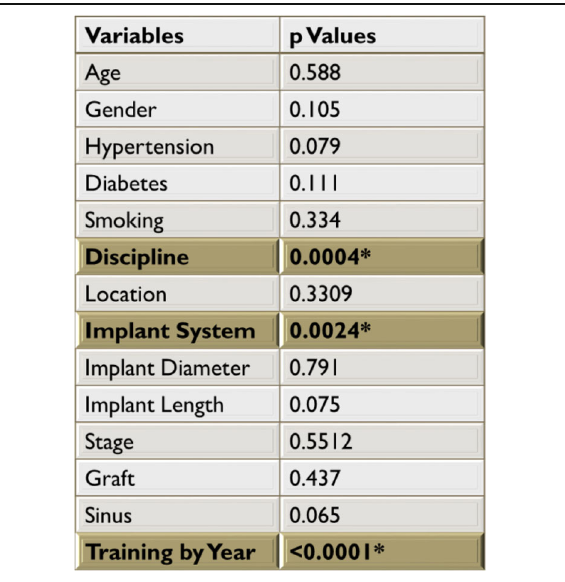
Table 2 Multiple logistic regression comparing each variable to implant